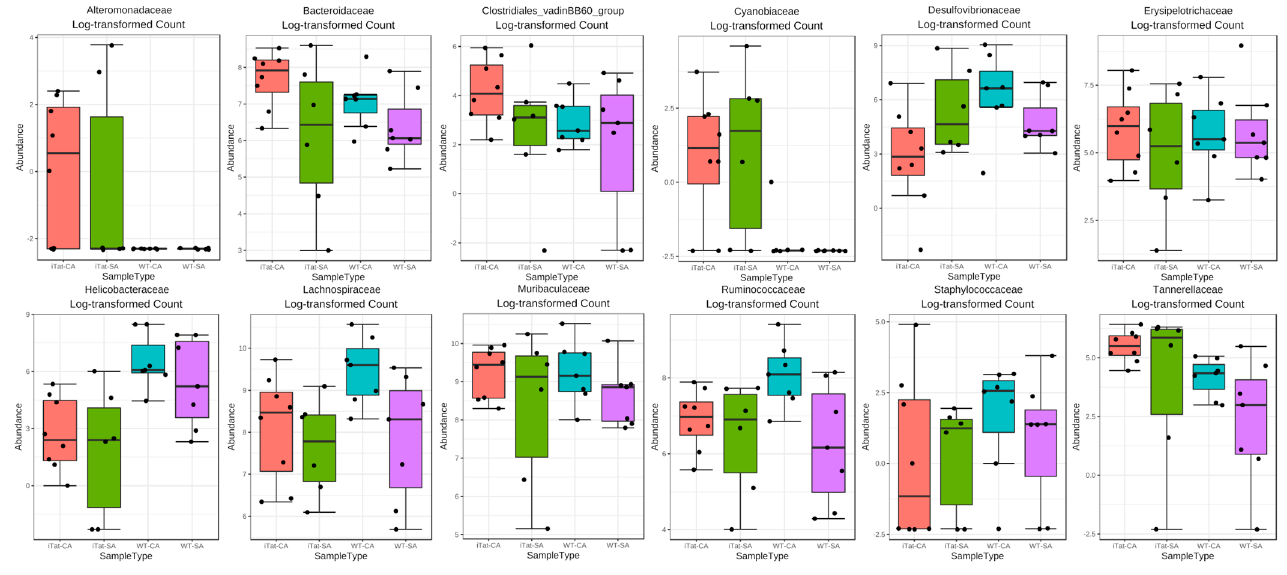
Figure 8. Effects of Tat expression and cocaine exposure on microbial abundance by family in the gut of 12-month male mice. Twelve families which were affected in either group were presented. The data were analyzed using Kruskal–Wallis test. The error bars were SD.